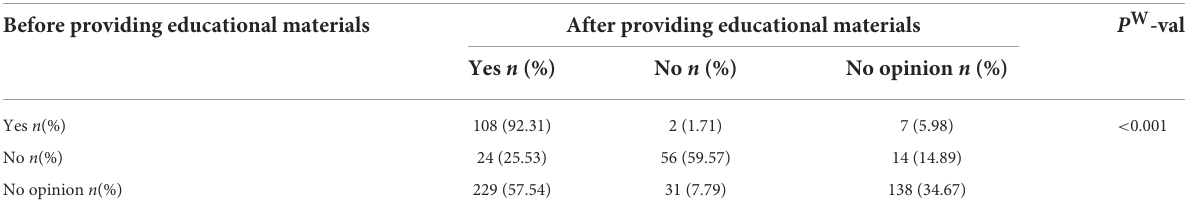
TABLE 5 Change in the attitudes of respondent toward the possibility of purchasing radiation-preserved food after providing educational